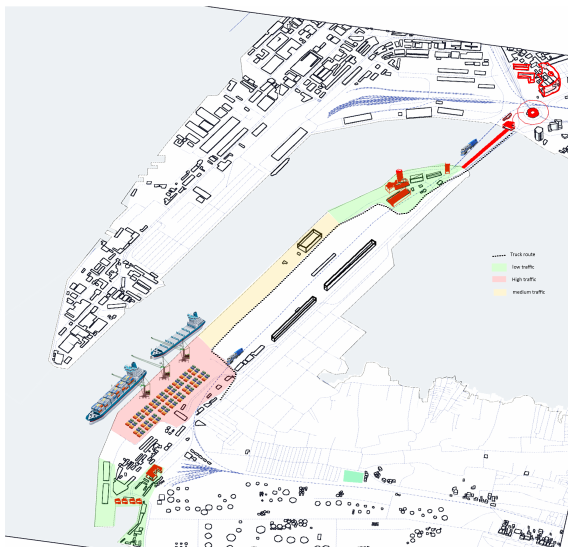
Figure 10. Traffic on the port to show the potential in opening areas for the public in low traffic zones, image by the first